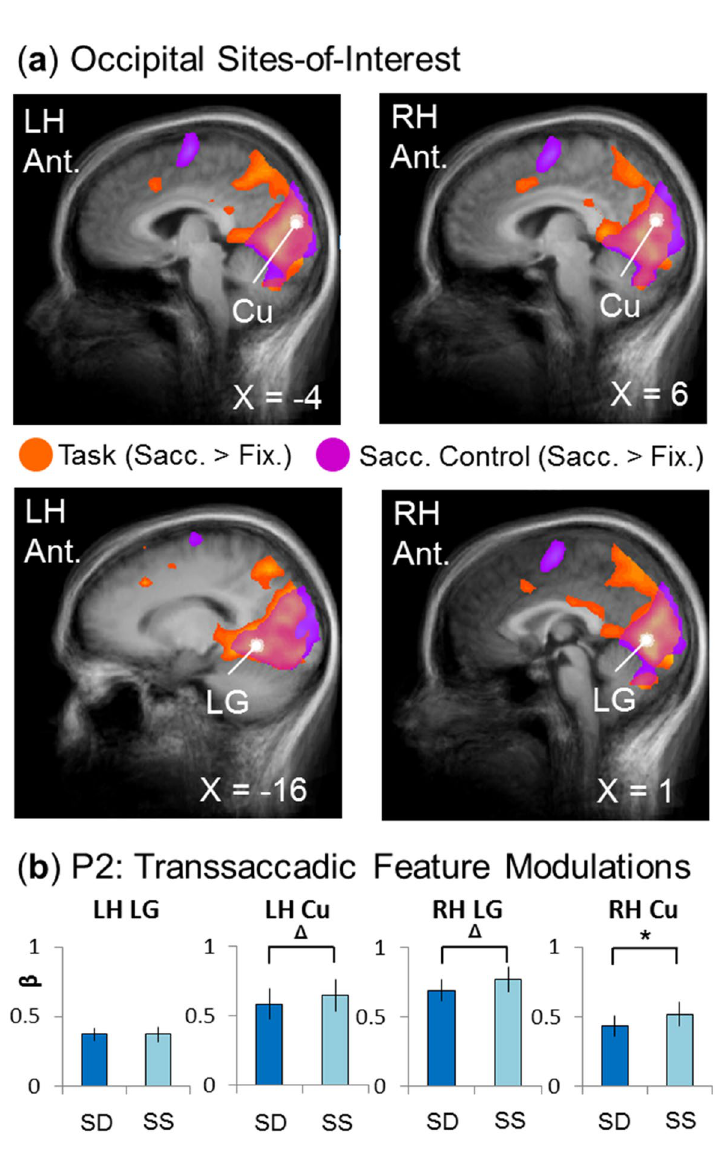
Figure 6. Testing feature specificity in occipital sites-of-interest. ( a ) The sites-of-interest within the occipital cortex were determined and are visualized on the slices of the averaged brains of all (n = 15) participants. (These regions are superimposed onto activation maps from an RFX GLM for the experimental transsaccadic data (n = 15; orange) and from the separate saccade control task (n = 12; fuchsia) (BrainVoyager QX v2.8; www. brain voyag er. com). The white dots represent the peak voxels of each site-of-interest. The top two panels show the location of left lingual gyrus (LG) and cuneus (Cu) (left and right, respectively), whereas the bottom two panels show the locations of the right LG and Cu (left and right panels, respectively). ( b ) Based on previous findings for enhancement within occipital regions (see main text), we tested prediction 2c (see Fig. 2) to determine if these occipital sites-of-interest show a feature-specific effect for spatial frequency. These effects would be consistent with greater β-weights for the Saccade/Same condition than for the Saccade/Different condition. Bar graphs show the extracted β-weights from each of the four regions, of which right Cu shows a statistically significant effect ( p < 0.05) and left Cu and left LG show a trend toward significance ( p < 0.10). Bar graphs show mean β-weights ± SEM analyzed using one-tailed repeated measures